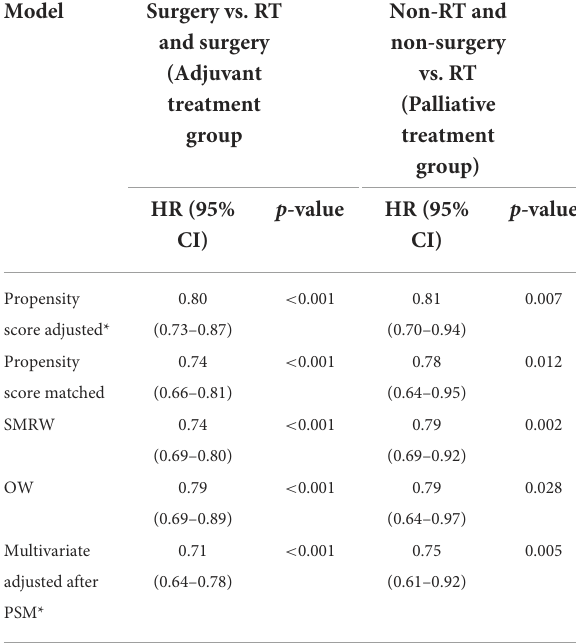
TABLE 5 Association between treatment group and overall mortality. Model Surgery vs.